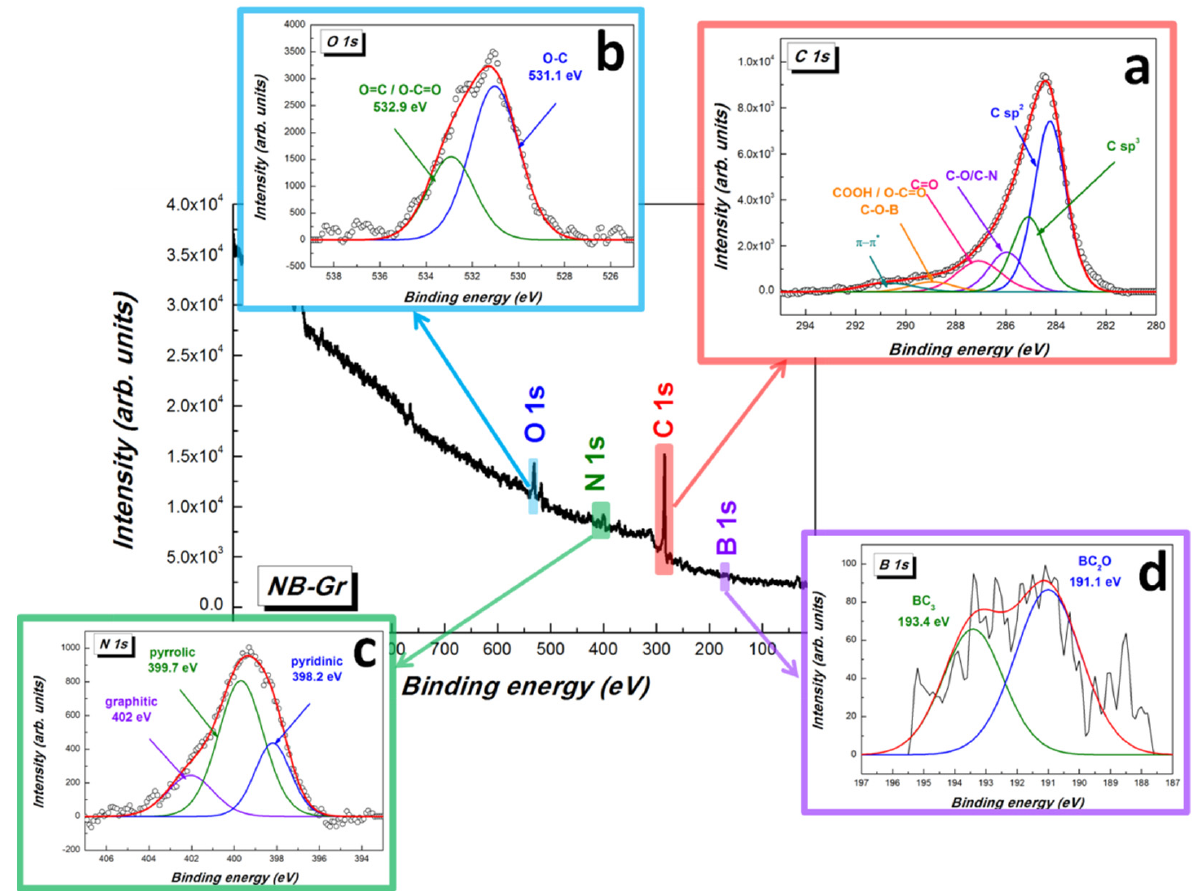
Figure 3. XPS survey spectrum and deconvolution of core level high-resolution C 1s ( a ) O 1s ( b ), N 1s ( c ) and B 1s ( d ) XPS spectra of N,B-co-doped graphene sample .